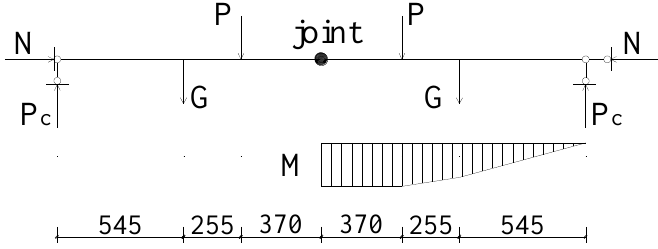
Figure A2. Illustration of bending moment calculation.